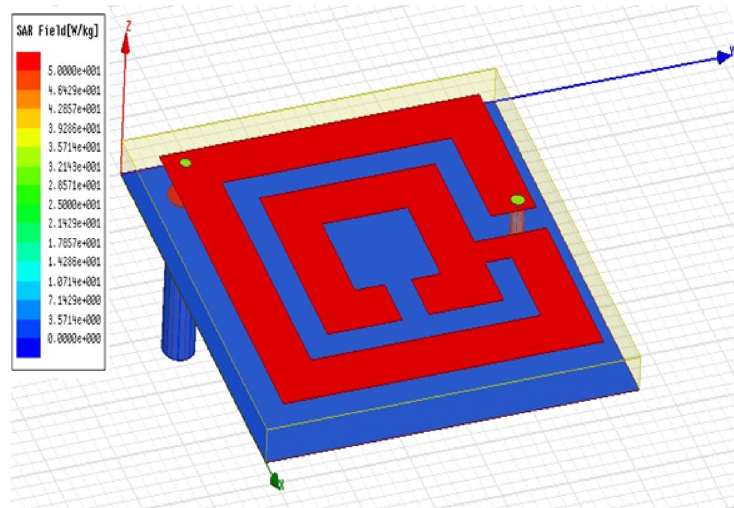
Figure 11. Simulated SAR of the proposed antenna.